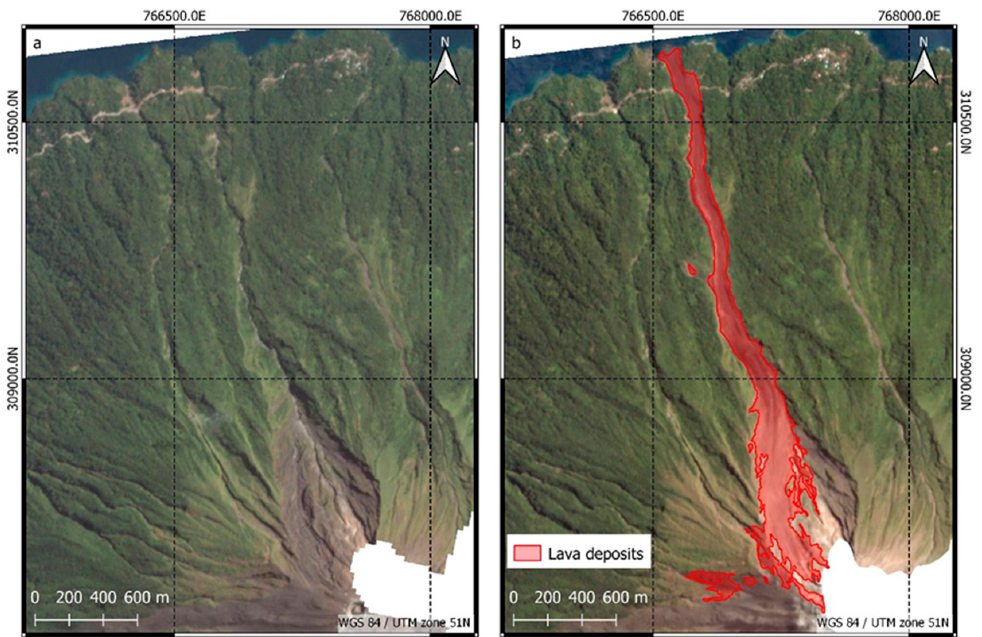
Figure 5. Classification result of the lava flow on the NNW flank of Karangetang (I). ( a ) PlanetScope pre-scene (19 July 2018). ( b ) Classified lava flow area with the post-scene (4 May 2019) in the background.